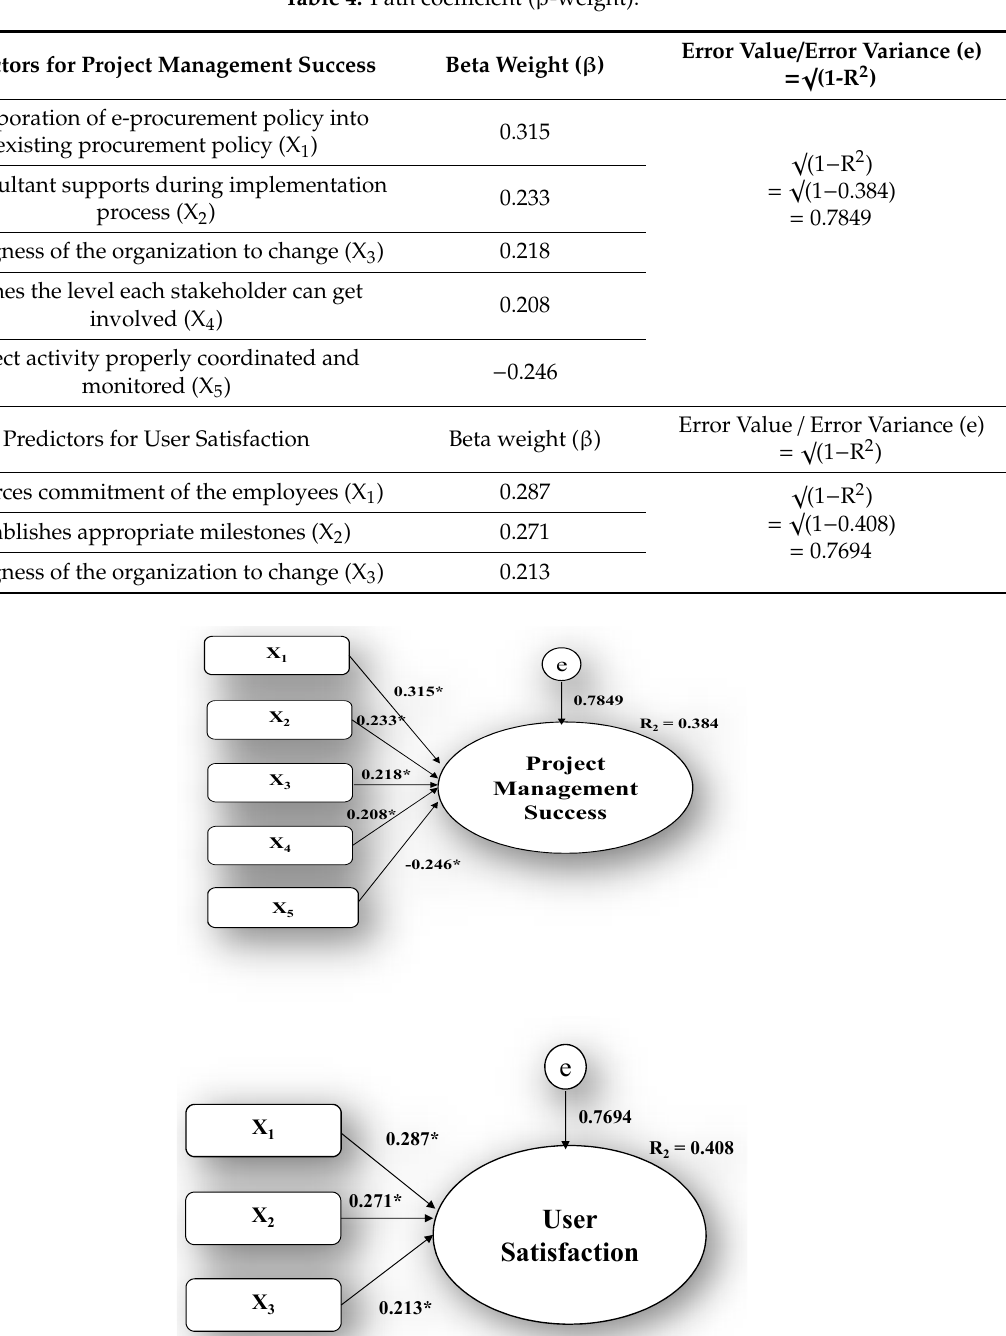
Figure 3. Predicted path model of e-procurement implementation success.